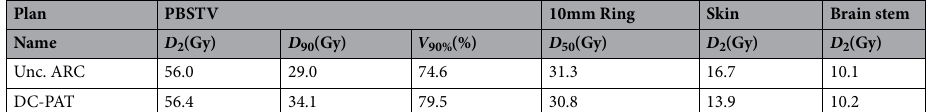
Plan PBSTV 10mm Ring Skin Brain stem